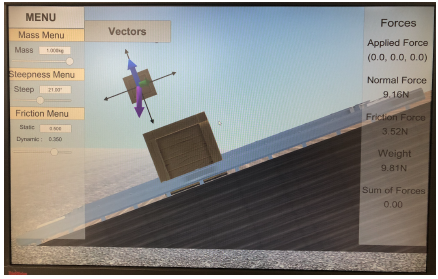
Figure 14. Inclined plane